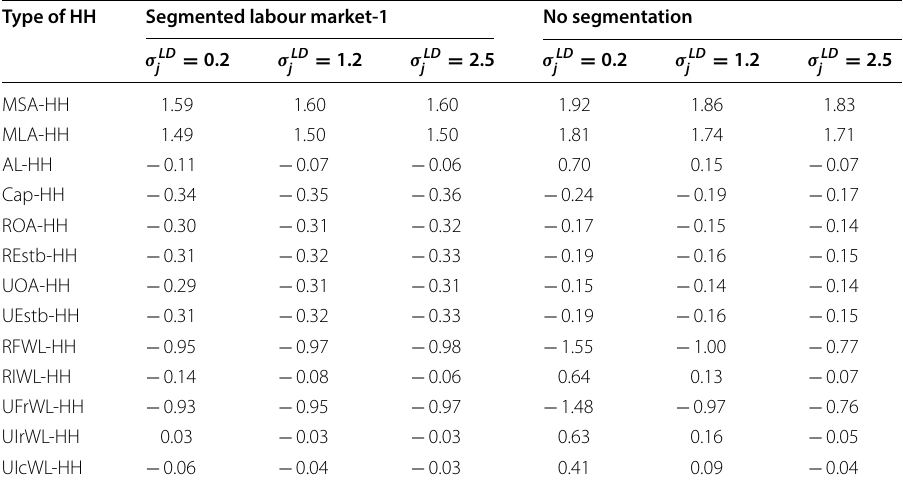
Table 6 (Scenario A1–A2:S1–S3) Change (%) in income of households due to 50% tariff cut Type of HH